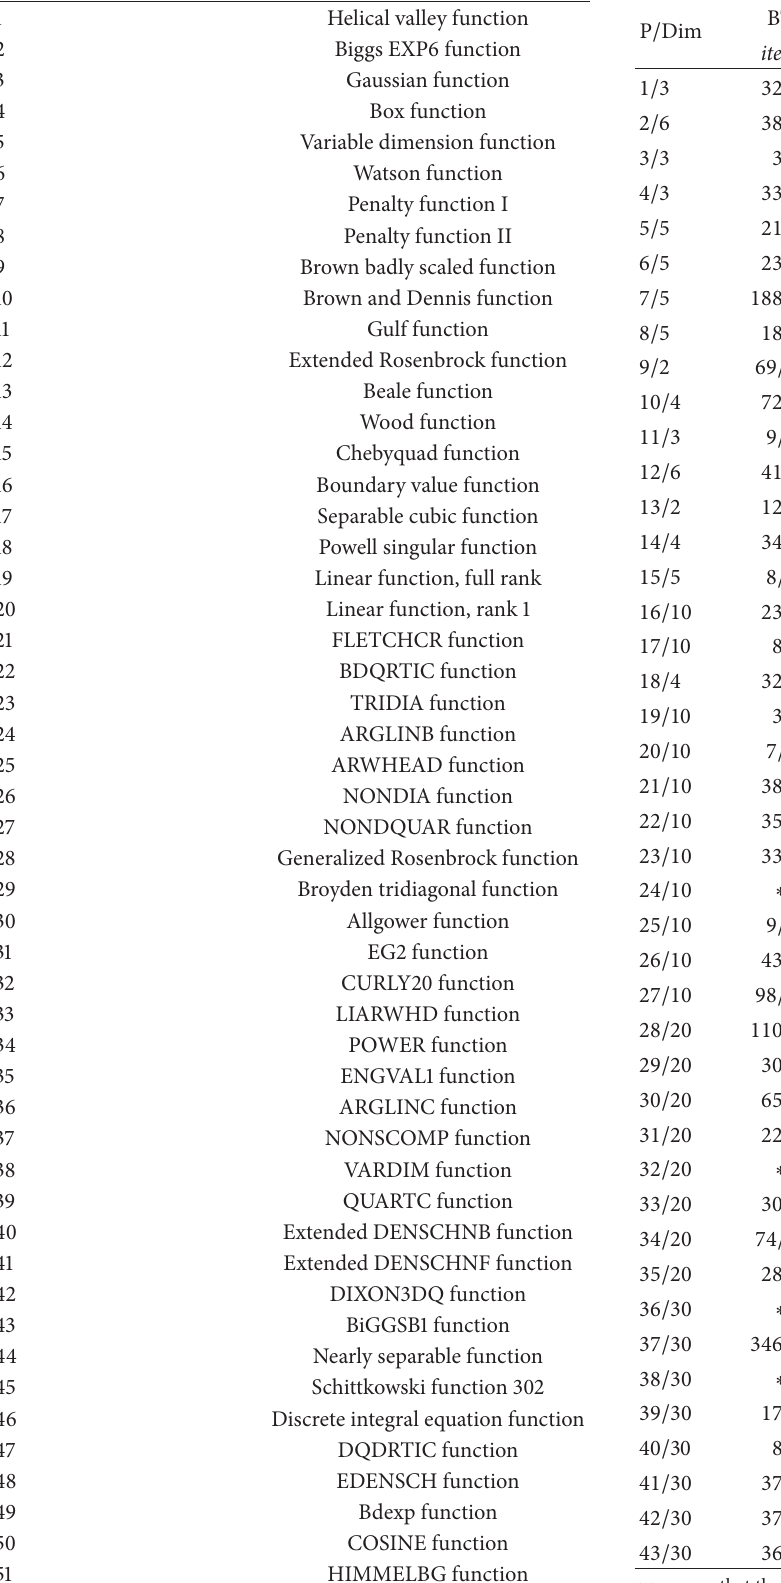
Table 1: Test problems. Table 2: Numerical comparisons for some small-scale test prob-